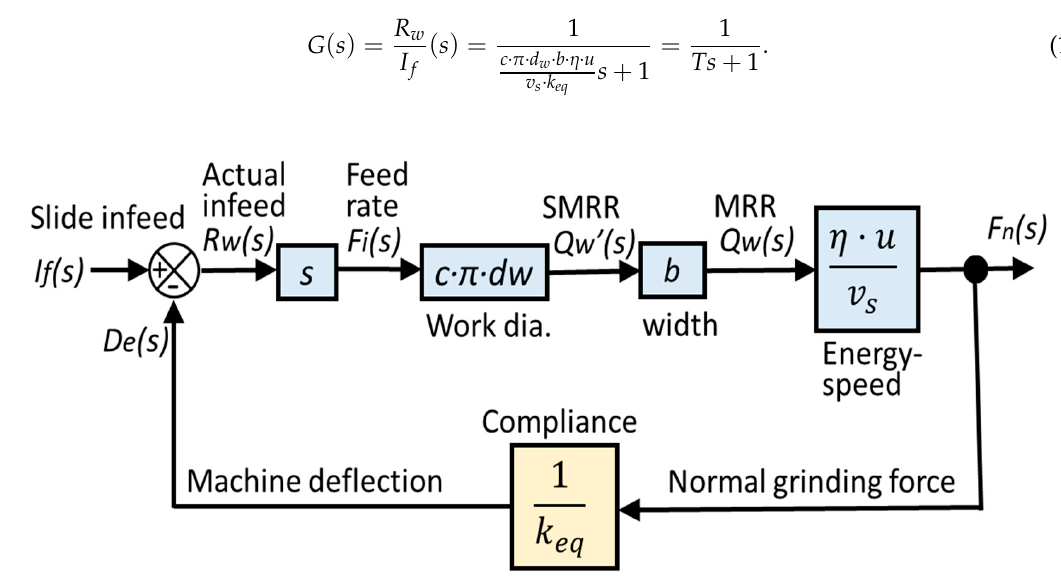
Figure 3. Block diagram of the plunge grinding system.